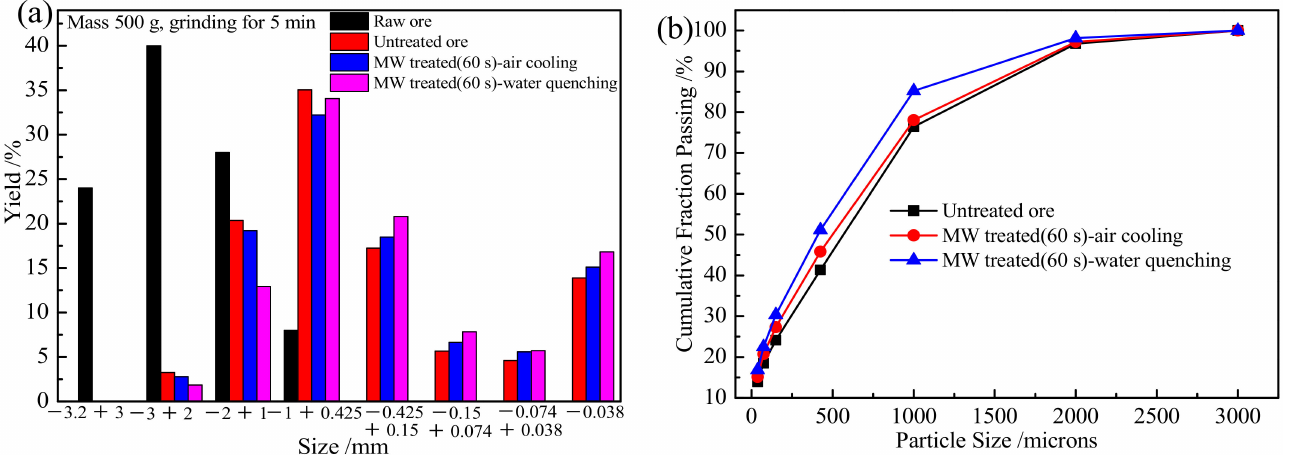
Figure 3. Effect of the cooling pattern on the particle size distribution after the microwave pretreatment: ( a ) yield and ( b ) cumulative fraction